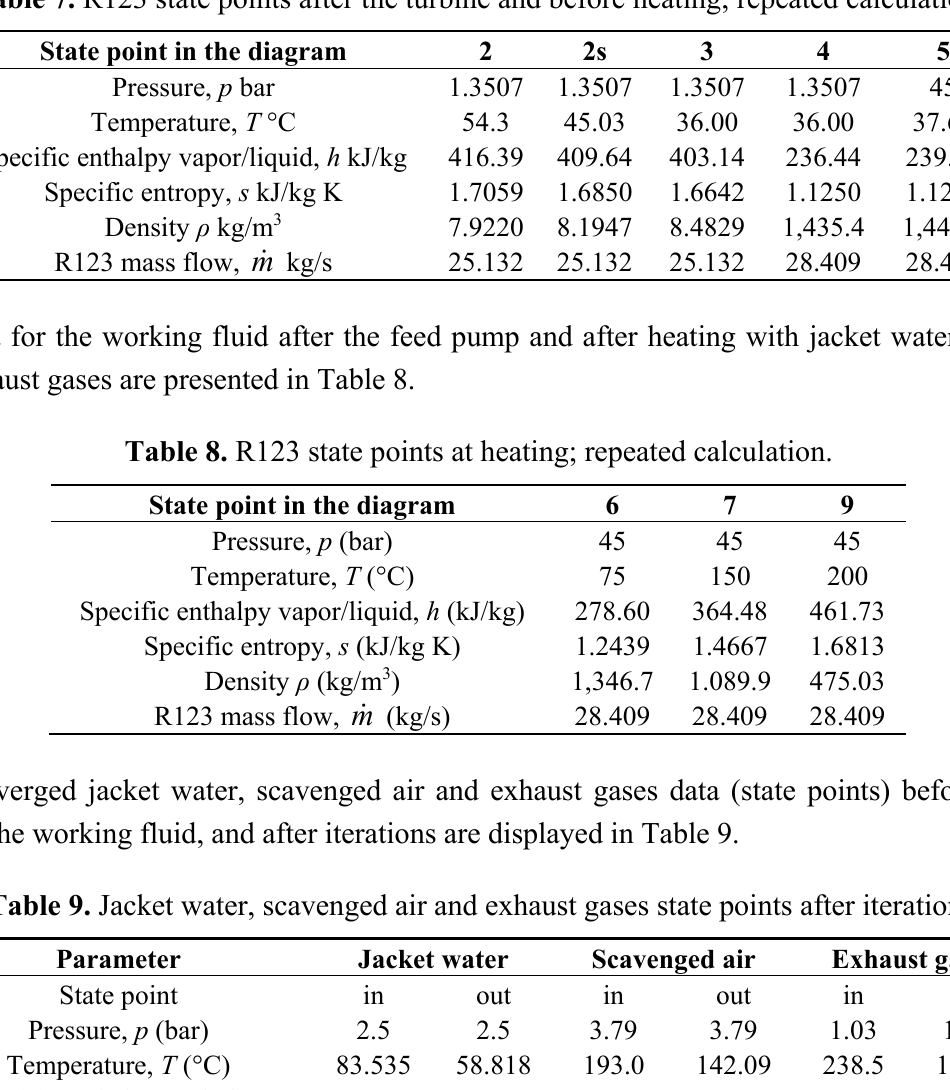
Table 7. R123 state points after the turbine and before heating; repeated calculation.